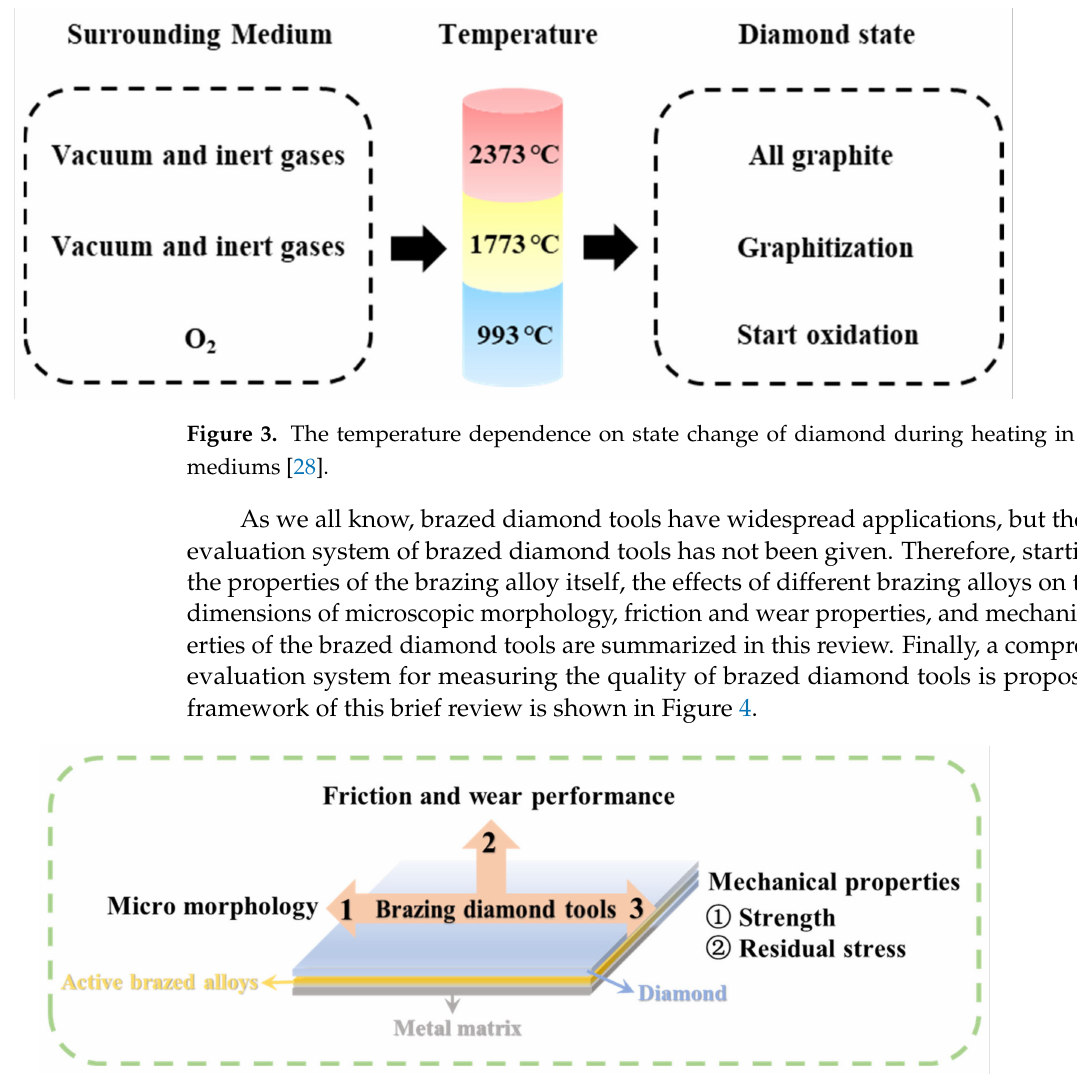
Figure 4. Quality evaluation system framework of monolayer brazed diamond